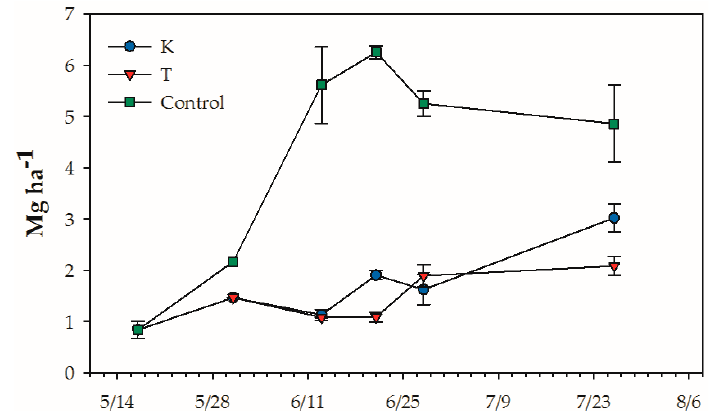
Figure A5. Clover biomass and standard error over the entire sampling period as a function of banded herbicide (K) and zone tillage (T) row management and with unmanaged clover (Control).